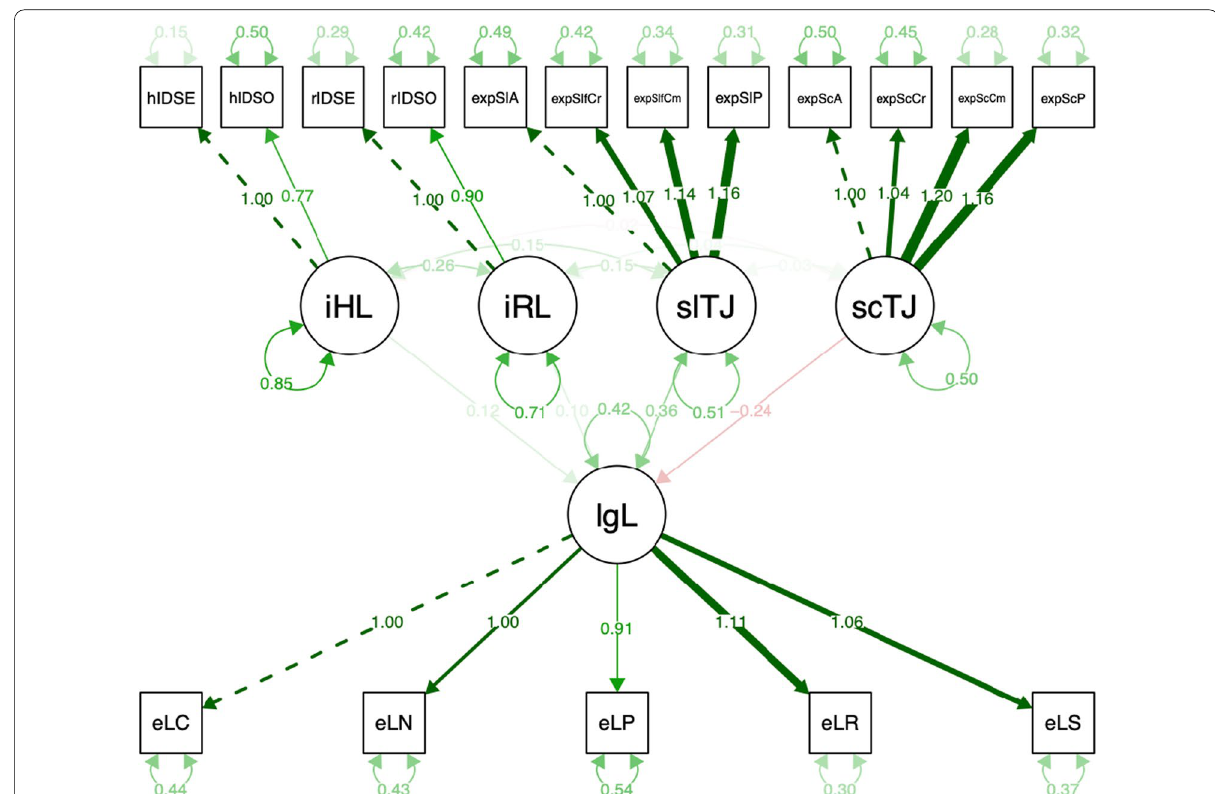
Fig. 3 Structural equation model (Study 4) in which a latent legal judgment variable [lgL] is predicted by a latent implicit hair attitude variable